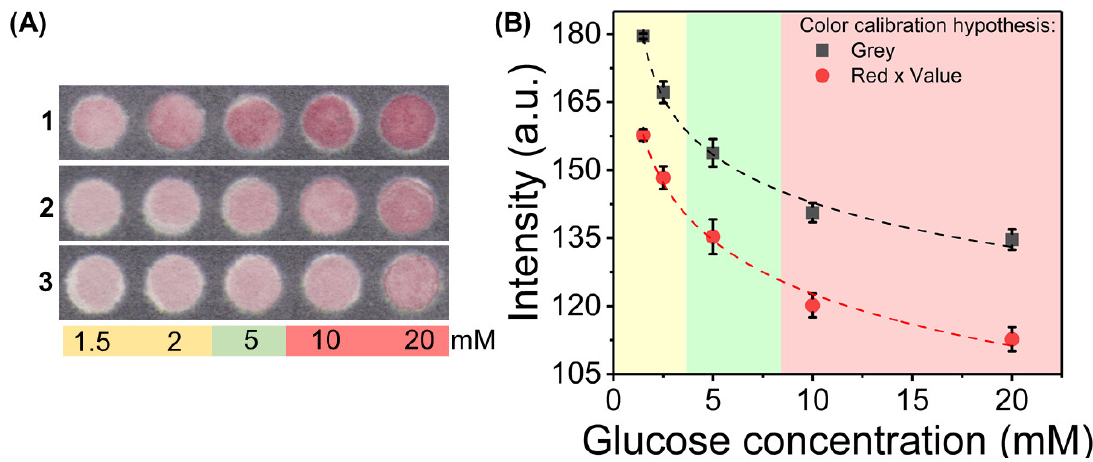
Figure 7. Assay performed with serum samples. ( A ) Color signals obtained for differently fold diluted serum samples (1–25%; 2–33%; 3–50%), with various spiked glucose concentrations. The color signals show a decrease of color intensity with the increase of serum concentration, due to the lower efficacy of protein removal. ( B ) Color signal calibration for 25% diluted serum samples (n = 5), showing that these complex samples lead to the same behavior of color signals, able to differentiate different blood glucose states, in a semi-quantitative approach.